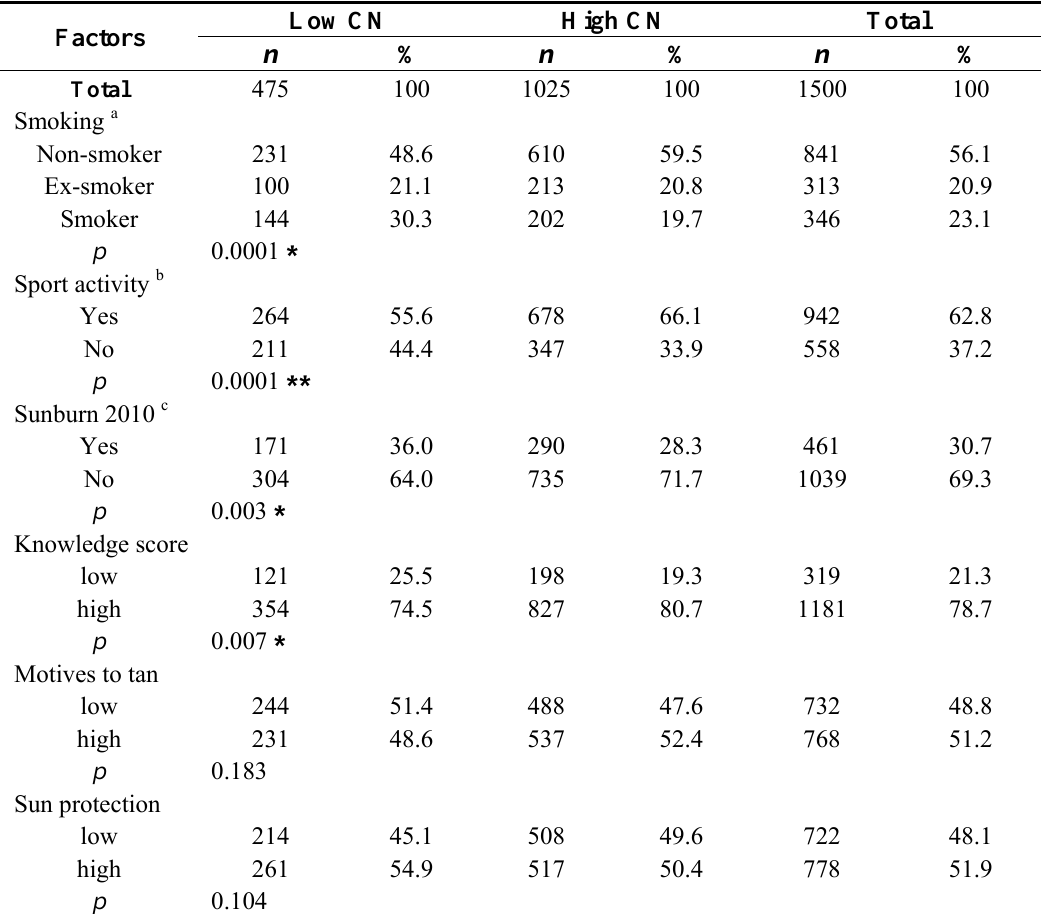
Table 4. Differences in sample characteristics regarding specifications of connectedness to nature (CN, low/high).